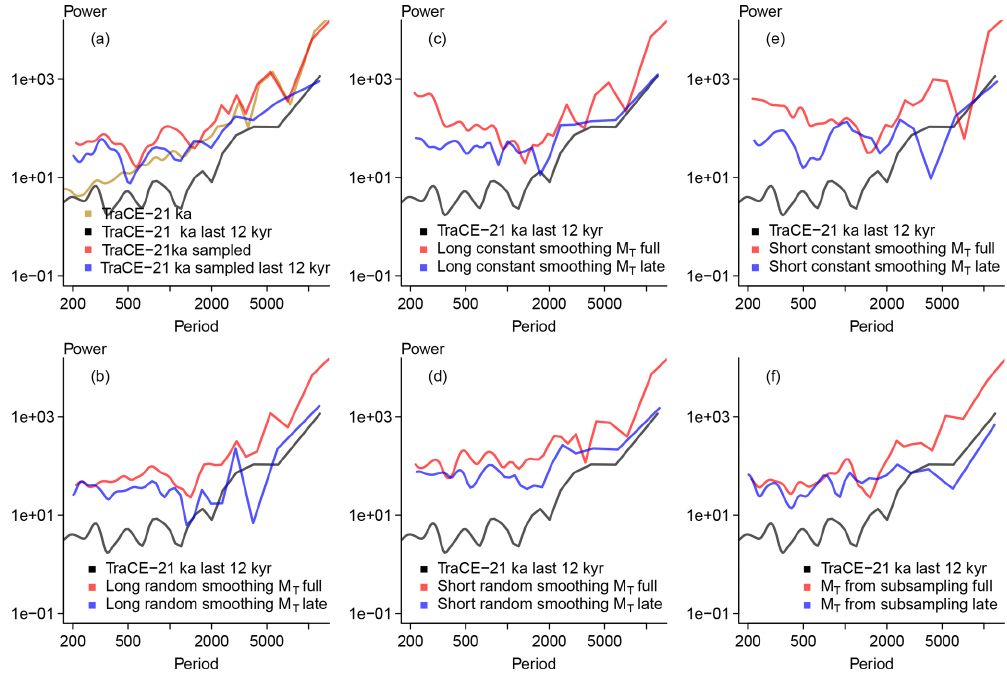
Figure 6. Wavelet-based power spectral densities (Mathias et al., 2004; McKay et al., 2019). Densities are weighted following Mathias et al. (2004) to smooth the records for ease of comparison. Lines are for records split up by the first 10k years of the records and the last 12k years of the records. Input data refer to the input data at 10-year intervals. All panels include the late input data from the TraCE-21ka simulation as black lines; red lines are in all panels for a full period record; blue lines are in all panels for the last 12k years of the version of a pseudoproxy. In addition to the input data from the TraCE-21ka simulation the panels show: (a) the sampled TraCE-21ka simulation input data, (b) the sampled pseudoarchive series with long average smoothing plus the effective dating error and the measurement noise (long random smoothing M T ), (c) the constantly smoothed record with a longer smoothing plus an AR(1) process and including the effective dating error and the measurement noise (long constant smoothing M T ), (d) the sampled pseudoarchive series with short average smoothing plus the effective dating error and the measurement noise (short random smoothing M T ), (e) the constantly smoothed record with a shorter smoothing plus an AR(1) process and including the effective dating error and the measurement noise (short constant smoothing M T ), (f) the subsampled data plus the effective dating error and the measurement noise ( M T from